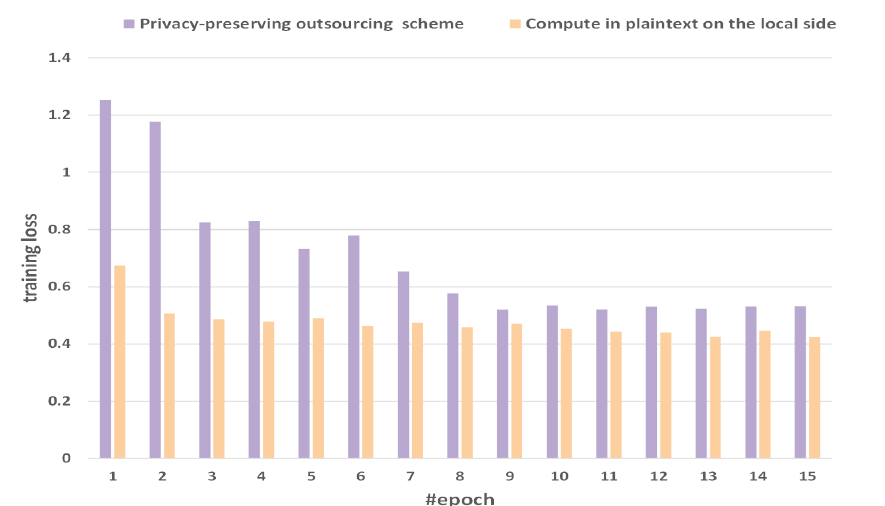
Figure 7. Comparison of training loss between the method of computing in plaintext on the local side and our